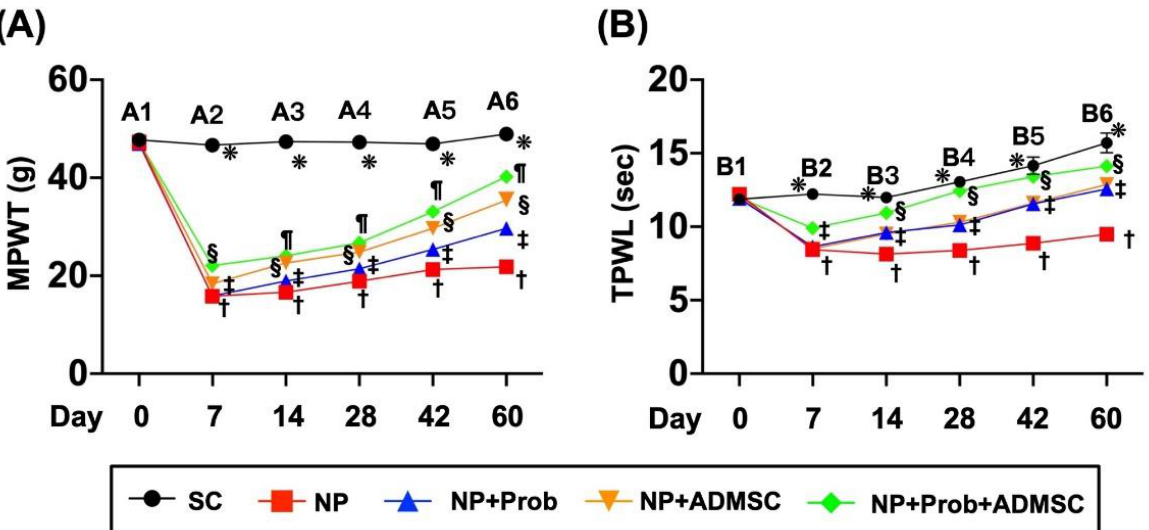
Figure 2. Time points of mechanical paw withdrawal threshold (MPWT) (g) and thermal paw withdrawal latency (TPWL) (Sec) in rats. ( A ) Left Panel: (A1) At day 0, the analytical results of MPWT were similar among the five groups. (A2) At day 7, the analytical results of MPWT, * vs. other groups with different symbols (†, ‡, §, ¶), p < 0.0001. (A3) At day 14, the analytical results of MPWT, * vs. other groups with different symbols (†, ‡, §, ¶), p < 0.0001. (A4) At day 28, the analytical results of MPWT, * vs. other groups with different symbols (†, ‡, §, ¶), p < 0.0001. (A5) At day 42, the analytical results of MPWT, * vs. other groups with different symbols (†, ‡, §, ¶), p < 0.0001. (A6) At day 60, the analytical results of MPWT, * vs. other groups with different symbols (†, ‡, §, ¶), p < 0.0001. ( B ) Right Panel: (B1) At day 0, the analytical results of TPWL were similar among the five groups. (B2) At day 7, the analytical results of TPWL, * vs. other groups with different symbols (†, ‡, §), p < 0.0001. (B3) At day 14, the analytical results of TPWL, * vs. other groups with different symbols (†, ‡, §), p < 0.0001. (B4) At day 28, the analytical results of TPWL, * vs. other groups with different symbols (†, ‡, §), p < 0.0001. (B5) At day 42, the analytical results of TPWL, * vs. other groups with different symbols (†, ‡, §), p < 0.0001. (B6) At day 60, the analytical results of TPWL, * vs. other groups with different symbols (†, ‡, §), p < 0.0001. Symbols (*, †, ‡, §, ¶) indicate significance for each other (at 0.05 level). All statistical analyses were performed using one-way ANOVA, followed by Bonferroni multiple comparison post hoc test (n = 10 for each group). SC = sham control; NP = neuropathic pain; Prob = probiotics; ADMSCs = adipose-tissue-derived mesenchymal stem cells; TPWL = thermal paw withdrawal latency; MPWT = mechanical paw withdrawal threshold.